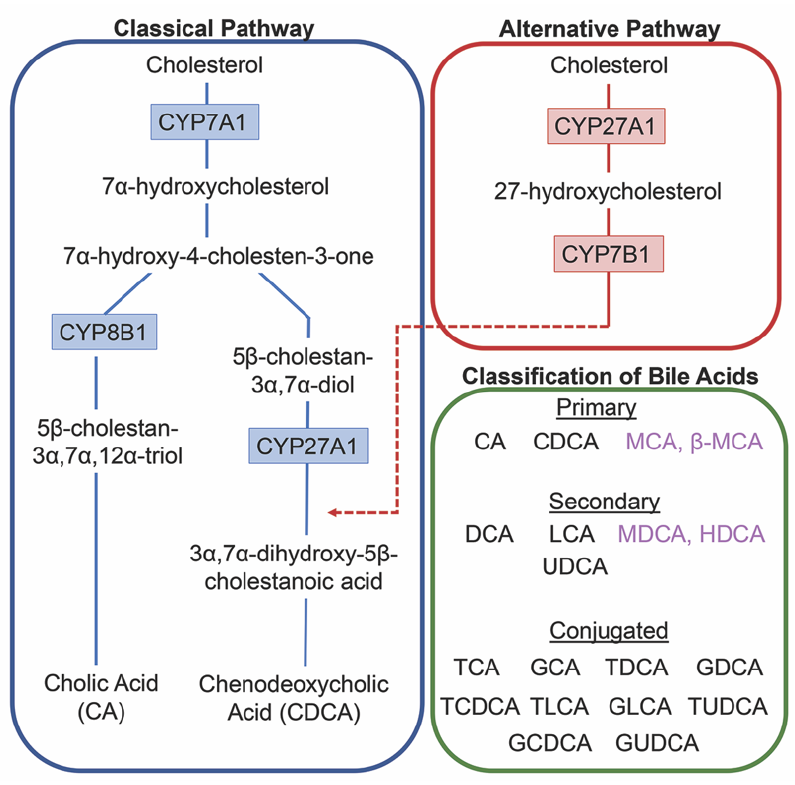
Figure 1. Bile acid synthesis pathways. The classic pathway for bile acid synthesis occurs in the hepatocytes of the liver via 7 α -hydroxylase (CYP7A1) converting cholesterol into 7 α -hydroxycholesterol. Primary bile acid cholic acid (CA) is formed after subsequent conversions from sterol 12 α -hydroxylase (CYP8B1) and chenodeoxycholic acid from sterol 27-hydroxylase (CYP27A1). In the alternative or acidic pathway, mitochondrial CYP27A1 in peripheral tissues convert cholesterol into 27-hydroxycholesterol. Oxysterol 7 α -hydroxylase (CYP7B1) is an additional assisting enzyme in this pathway and the resulting products feed back into the liver, indicated by the red arrow feeding into the classical pathway under CYP27A1. Primary and secondary bile acids specific to rodents are listed in purple. Bile acids can become conjugated with glycine or taurine after interactions with gut